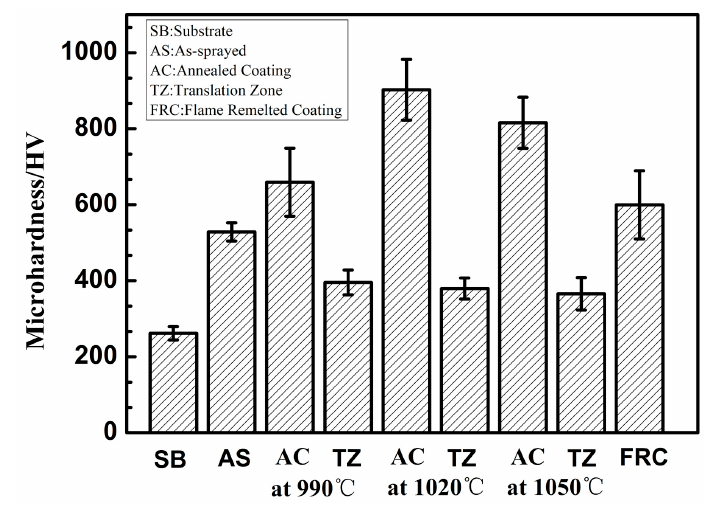
Figure 10. Microhardness of the coatings and the substrate.